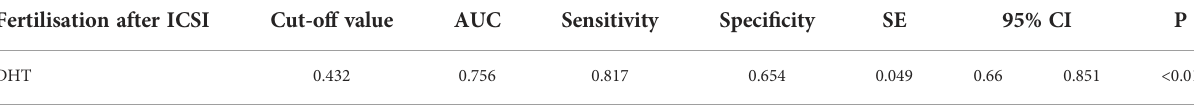
TABLE 4 Receiver operating characteristic curve analysis of DHT levels in FF for fertilised oocytes from 136 matched oocytes. Fertilisation after ICSI